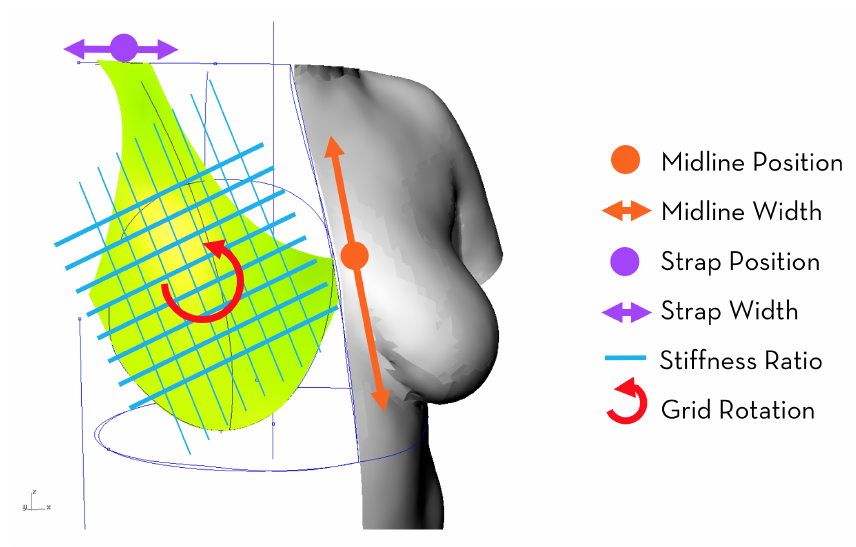
Figure 11. Diagram and legend of variables used in bra